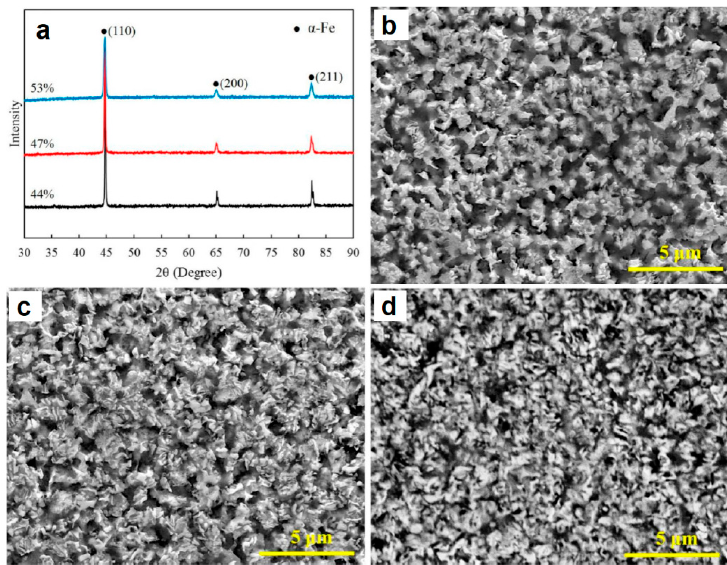
Figure 16. XRD patterns ( a ) and structure of porous iron ( b – d ) prepared by pressureless SPS from the pre-compacted iron nitride powder (( b ) porosity 44%, ( c ) 47%, and ( d ) 53%). Reprinted from Cui et